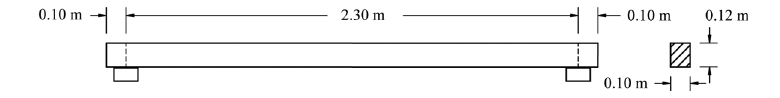
Fig. 2. Dimensions of the tested reinforced concrete beam